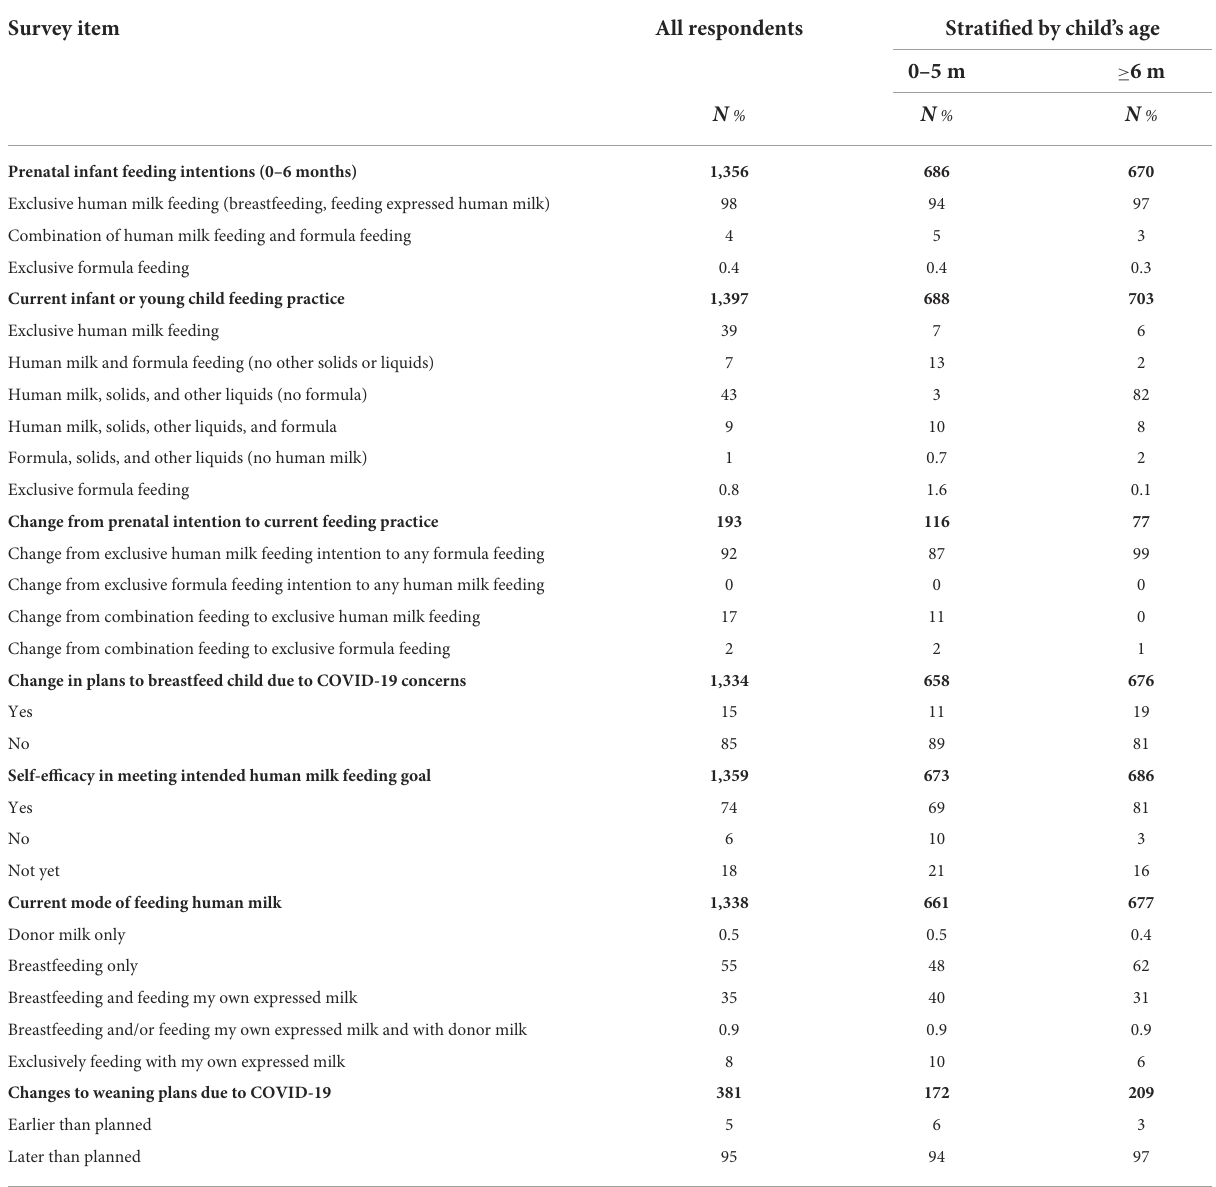
TABLE 3 Infant and young child feeding practices among survey respondents, ages 18 years and older, stratified by their child’s age, March–May 2020. Survey